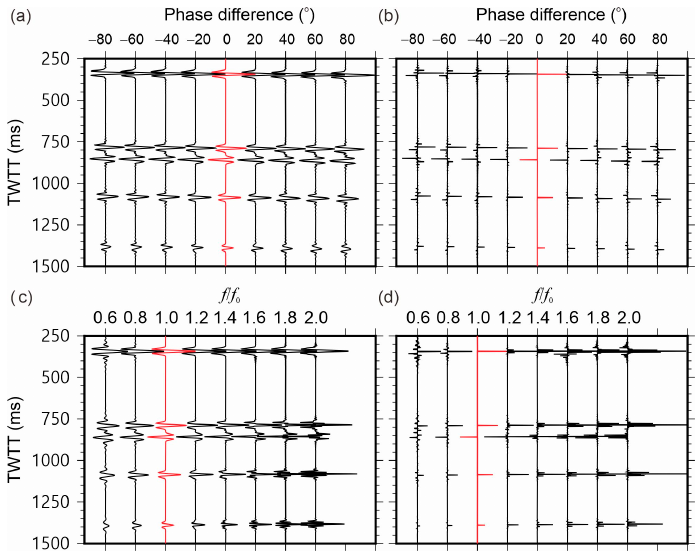
Figure 8. Wavelet sensitivity tests for ITD as in Figure 7 but with N = 1000.